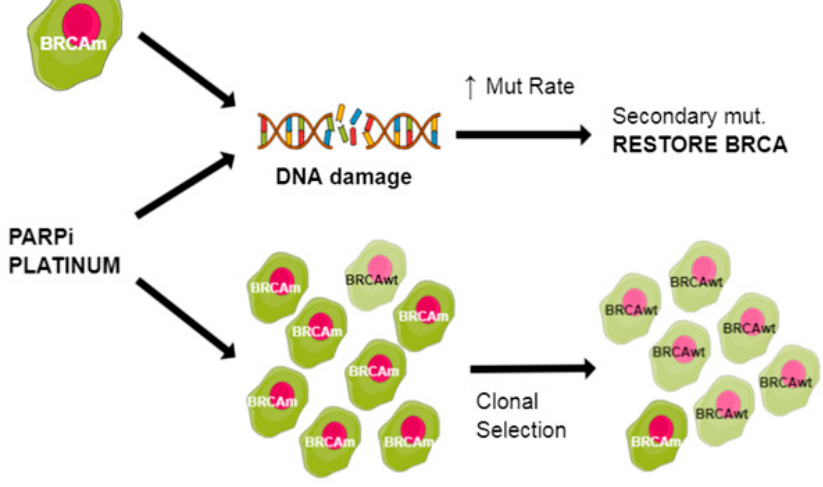
Figure 3. Potential mechanisms to restore BRCA function.